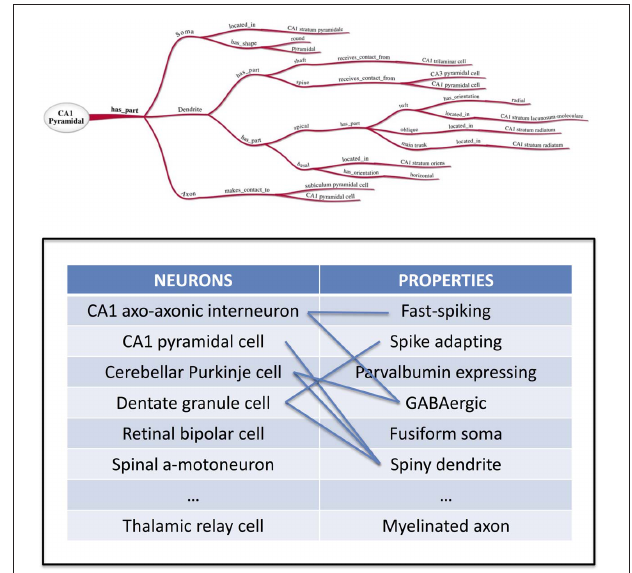
FIGURE 1 | Ontological Graphical Depiction (courtesy of the INCF Neuron Registry task force) and Neuron Registry Establishment → and illustration of the many-to-many relationship between neurons and their properties. The Neuron Registry will constitute a resource to browse and search neuron types based on their properties, and properties based on the neuron types in which they are